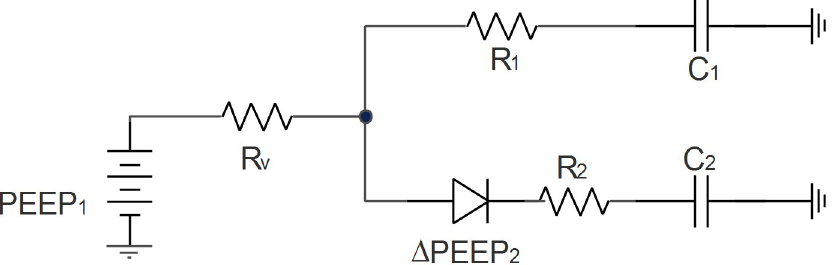
Fig 15. Linear lumped element model scheme of exhalation. The total charge in capacitors at time t = 0 corresponds to the air volume in each lung at the end of inspiration.